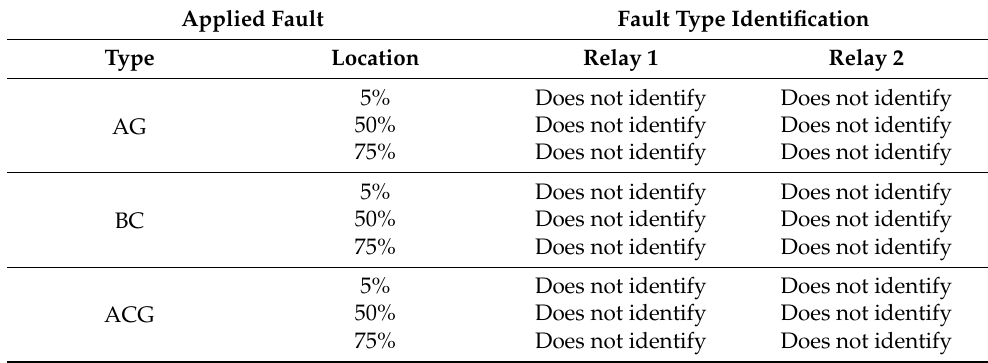
Table 2. Fault type identification of relays for high impedance faults.